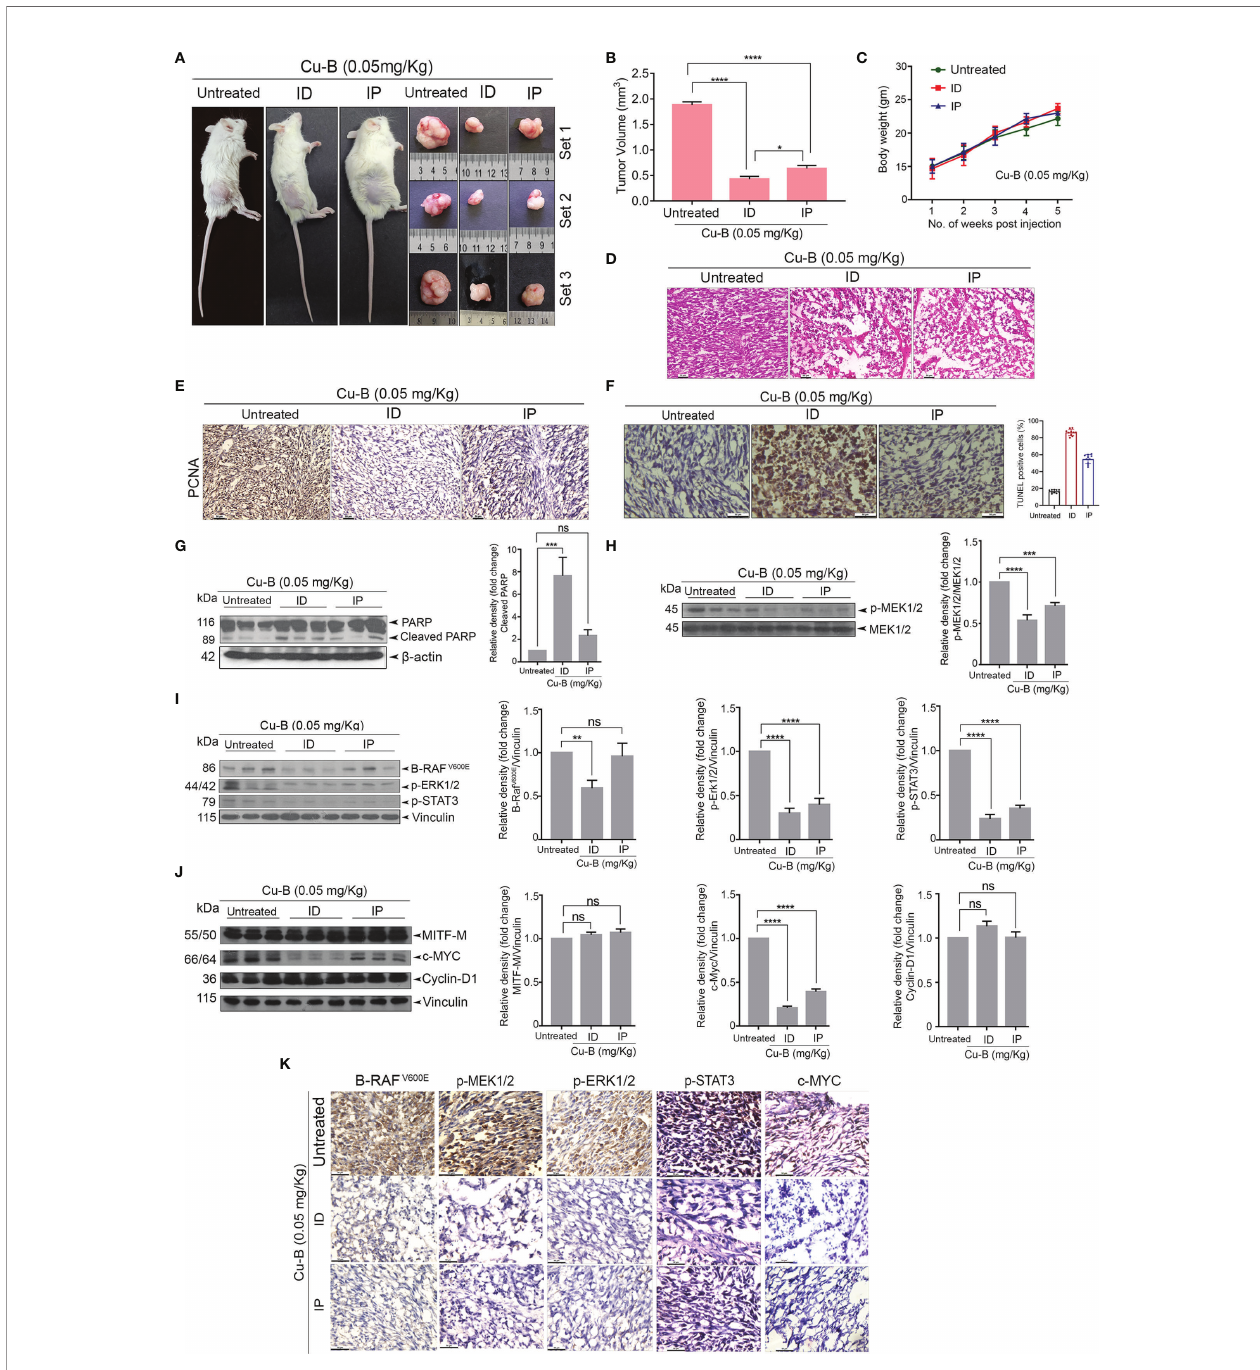
FIGURE 5 | Cu-B suppresses tumor development in a NOD-SCID murine model of human melanoma (A) . Representative photographs of Cu-B treated NOD-SCID mice bearing A375 xenografts and the excised tumors. (B) Cu-B represses the tumor volume in Cu-B treated melanoma-bearing mice. (C) Cu-B treatment unalters the bodyweights of mice throughout the study period. (D) Histopathological evaluation of tumor tissue isolated from mice groups. Formalin- fi xed cryosections were H and E stained. (E) IHC analysis on the expression of PCNA in tumor tissues of mice groups . (F) The apoptosis induced by Cu-B in the tumor tissues was con fi rmed by TUNEL assay (G) Immunoblot analysis demonstrating enhanced cleavage of PARP in the tumor lysates of Cu-B treated mice. (H – J) Immunoblot analysis showing the effect of Cu-B on key survival signals in melanoma, B- RAF V600E , p-MEK1/2, p-ERK1/2, p-STAT3, c-MYC, Cyclin-D1, and MITF-M, as evidenced in the tumor lysates. (K) IHC analysis on the expression of B- RAF V600E , p-MEK1/2, p-ERK1/2, p-STAT3, and c-MYC in tumor tissues of mice groups. Data are representative of three independent experiments (Mean±SEM) and P-values are calculated using one-way ANOVA. ****P ≤ 0.0001, ***P ≤ 0.001, **P ≤ 0.01, *P ≤ 0.1 and ns ≥